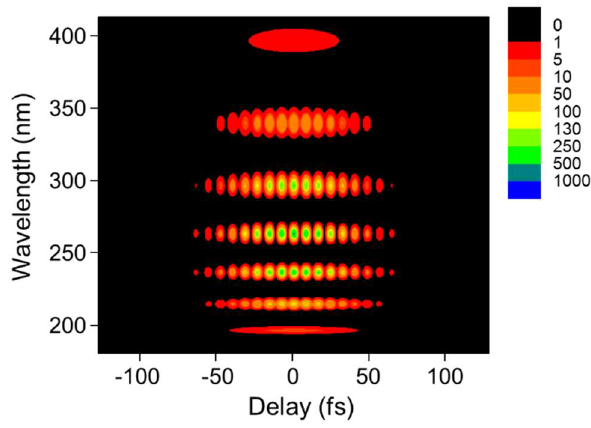
Figure 6. Calculated FROG trace.